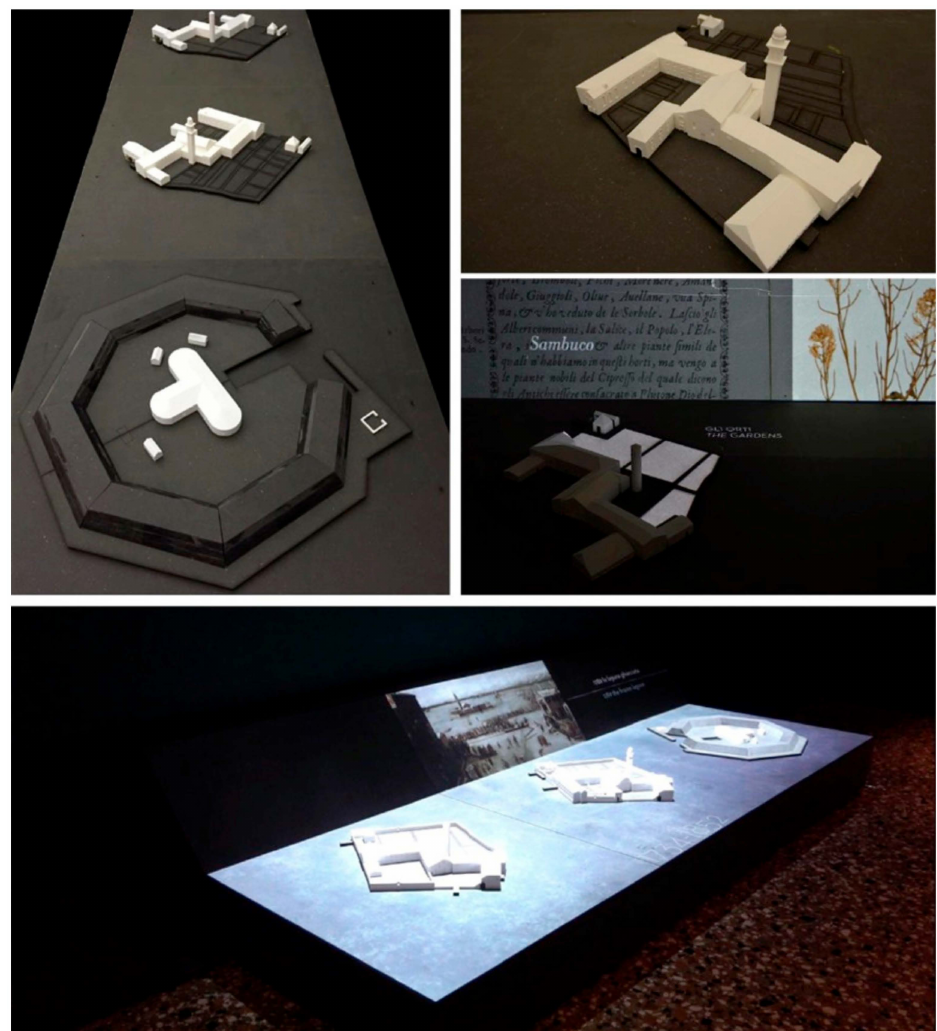
Figure 1. Printed three-dimensional models for a video-mapping installation about the history of the Venetian lagoon and its